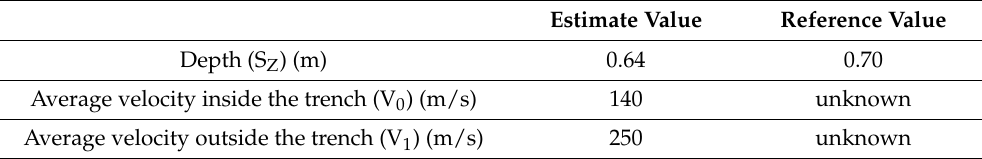
Figure 21. The inverse of the squared error between the estimated delay times and the delay times calculated by Model M2. For this display, the velocity outside the trench V1 is fixed at the estimated value. Table 6. Estimation obtained with least squares from Model